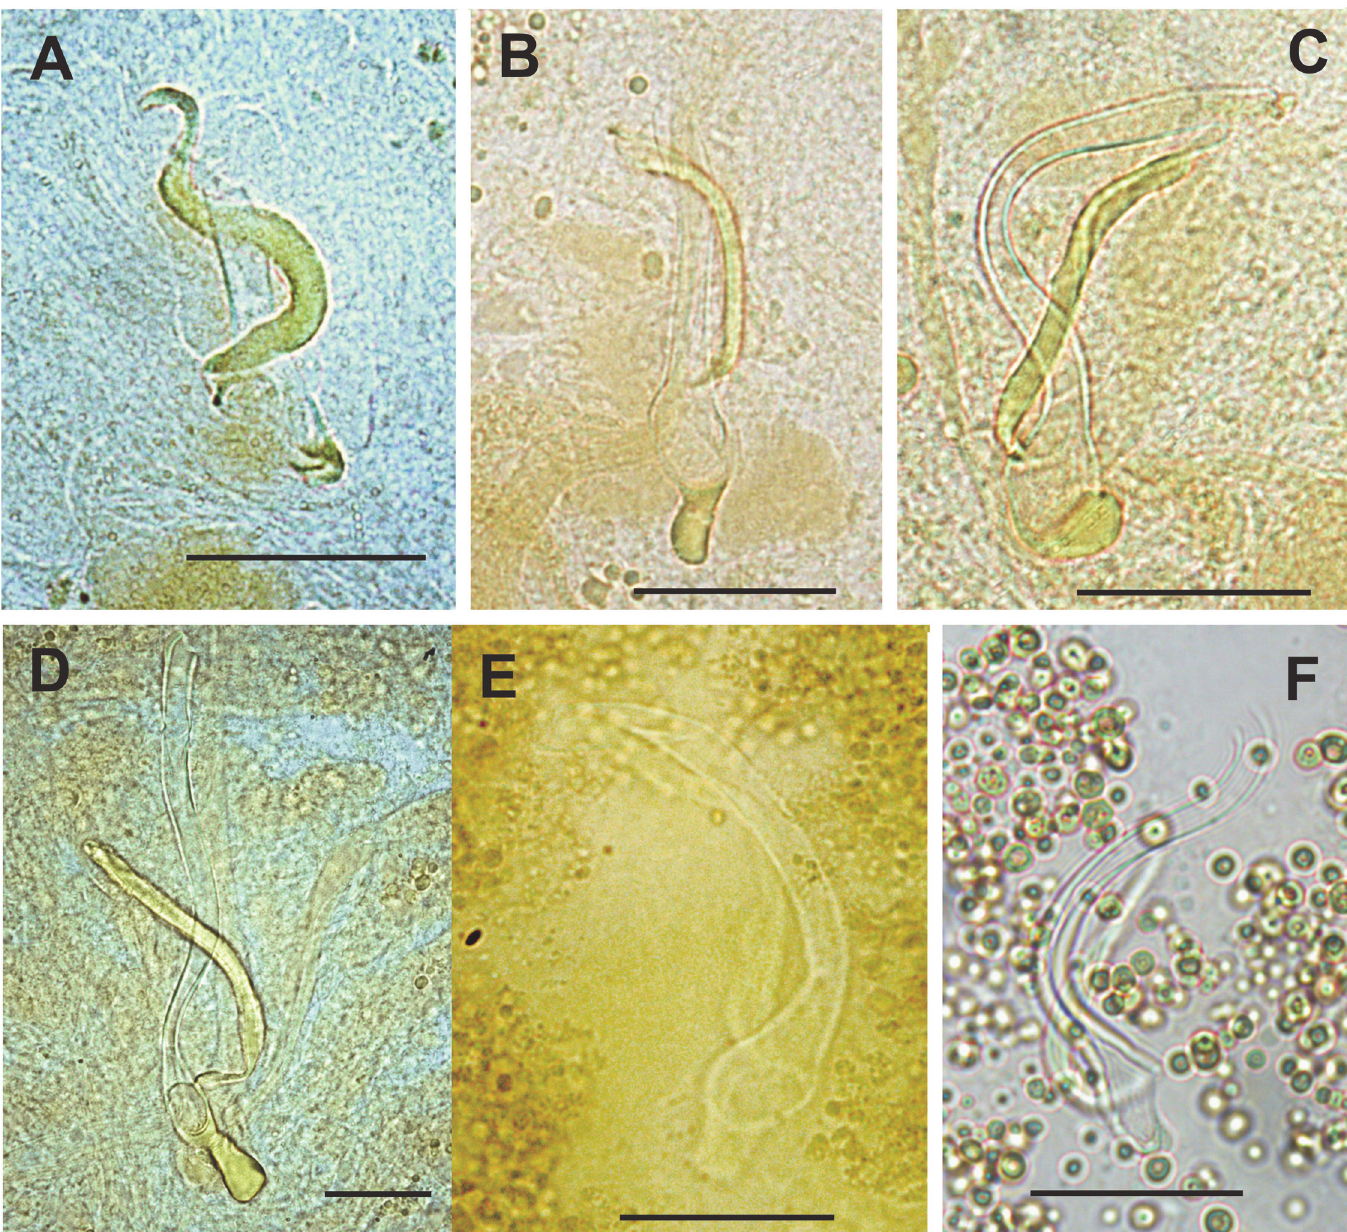
Fig 8. Male genital morphology of the newly described Cichlidogyrus species infecting Simochromis and Pseudosimochromis cichlids. Micrographs depict the male copulatory organ of A. C . raeymaekersi sp. nov. B. C . muterezii sp. nov. C. C . banyankimbonai sp. nov. D. C . georgesmertensi sp. nov. E. C . franswittei sp. nov. F. C . frankwillemsi sp. nov. Scale bar = 20 μ